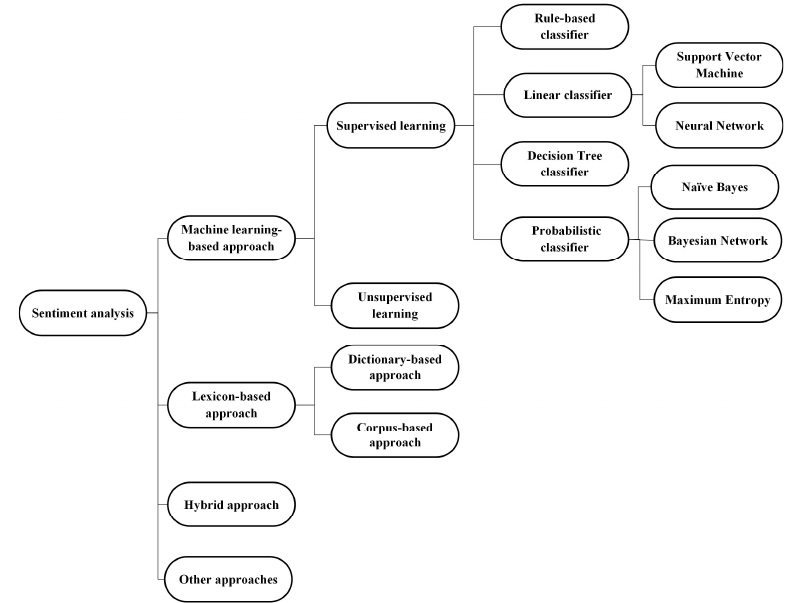
Figure 2. The taxonomy of sentiment